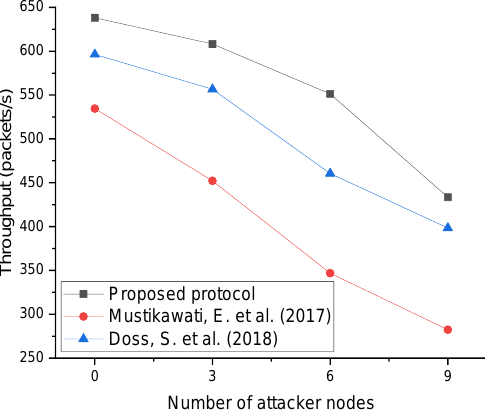
Figure 12. Nodes’ data throughput under Jellyfish periodic drop attacks [20,37]. Figure 12. Node s’ data throughput under Jelly fish periodic drop attacks [20,37].